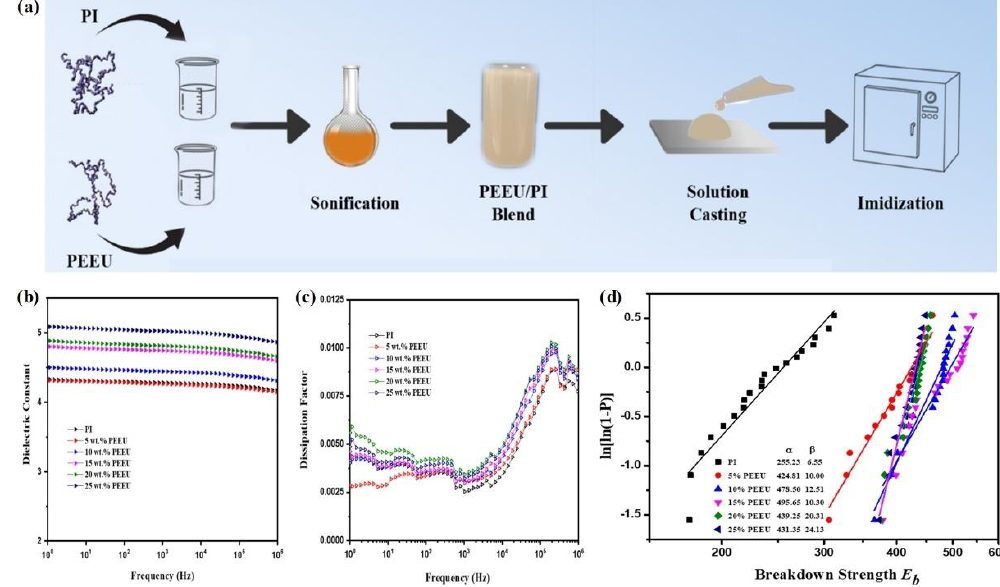
Figure 5. ( a ) Schematics of the synthesis process of PEEU/PI blend films. ( b , c ) The dielectric constant ( b ) and dissipation factor ( c ) of PEEU/PI blend films with various ratios as a function of frequency at ambient temperature. ( d ) Weibull breakdown strength of PI and PEEU/PI blend films at ambient temperature (measured at 10 3 Hz). Reproduced with permission from Ref. [60]. Copyright 2017, Wiley – VCH.